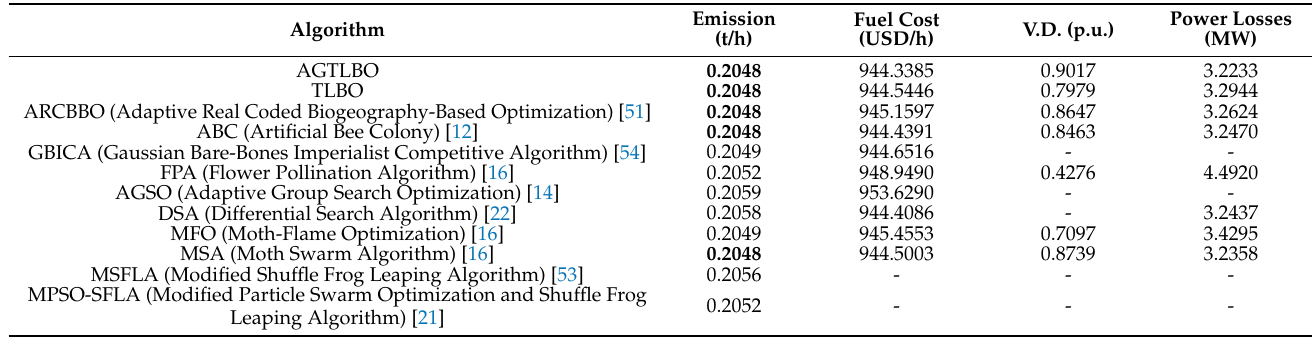
Table 4. Optimal results by different algorithms for Case